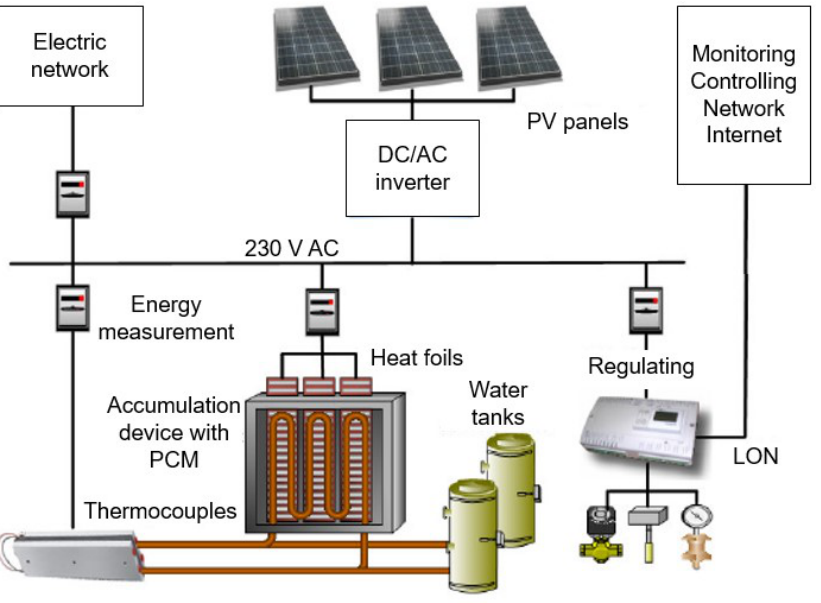
Figure 4. Scheme of the whole technology.